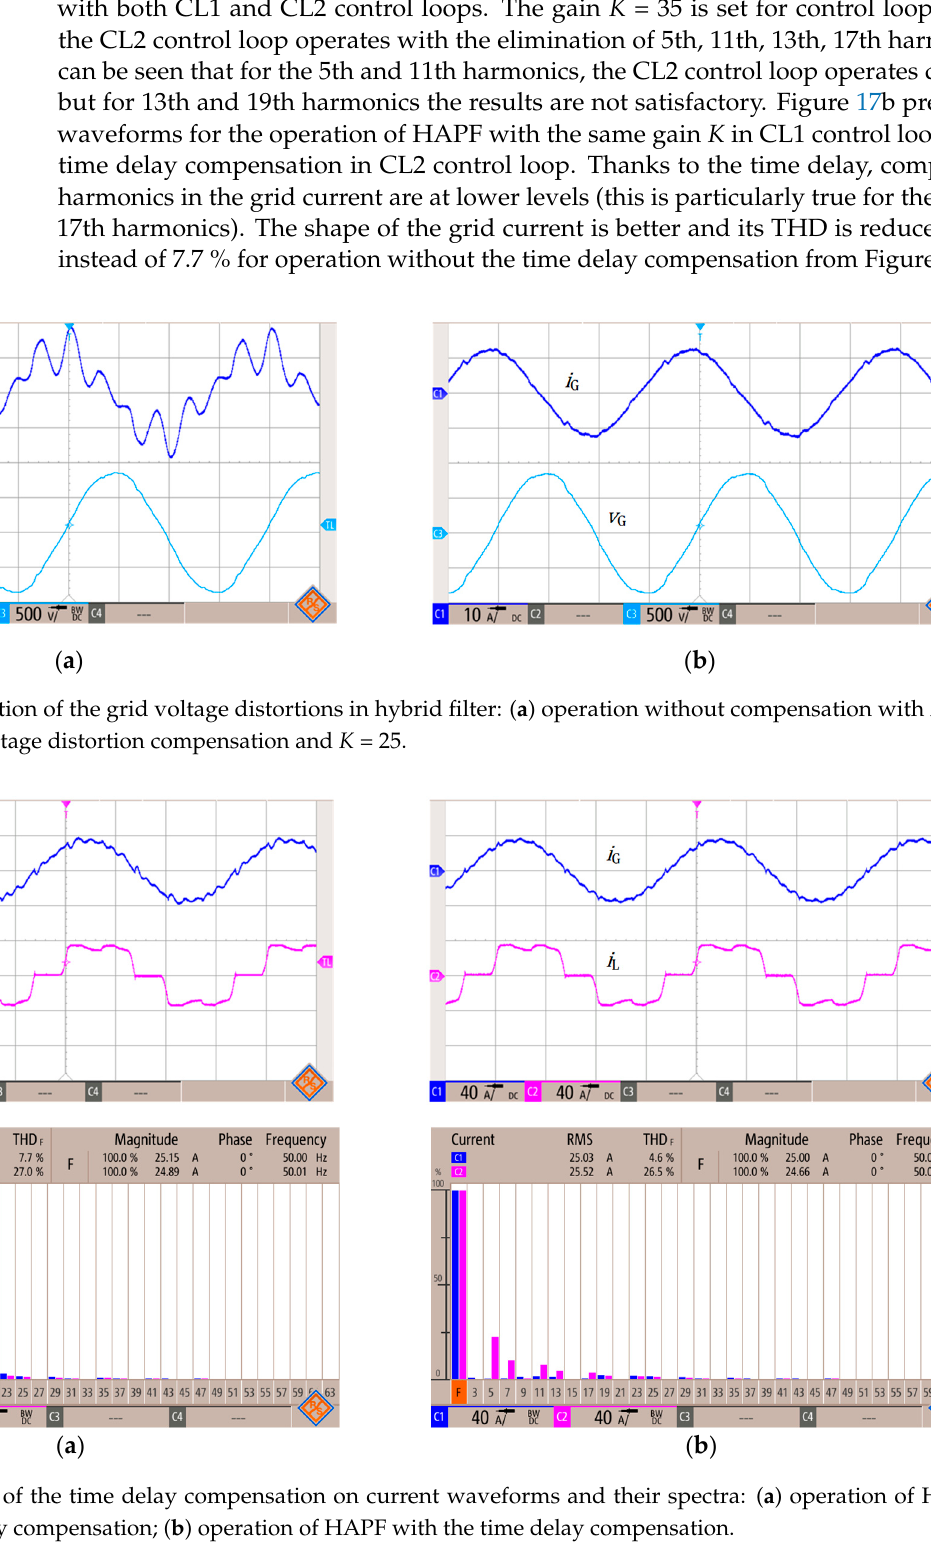
( b ) Figure 18. Operation of HAPF with the load Ld1: ( a ) the grid current, the load current and the power converter voltage waveforms; ( b ) harmonic spectrum of the grid and the load currents. Table 3. Comparison of the load currents and the grid currents for HAPF with the load Ld1. Harmonic